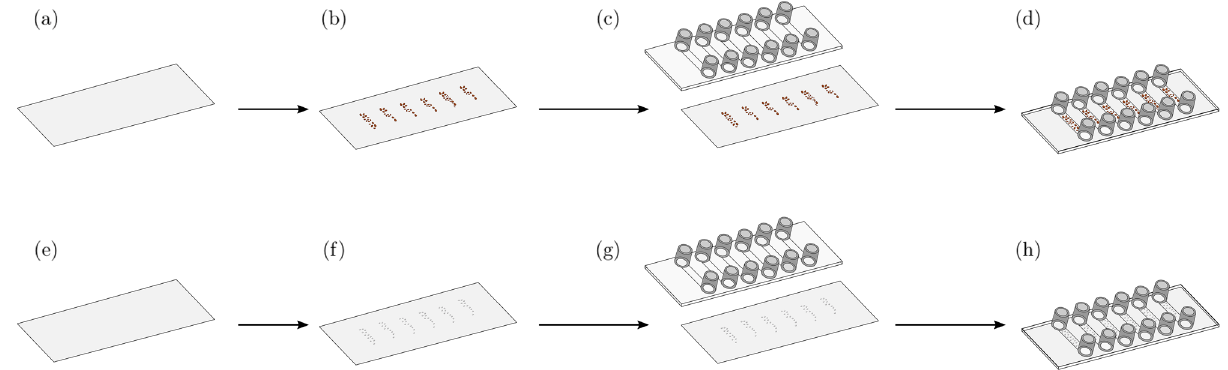
Figure 1. Fabrication and assembly process of sample cells with incorporated calcite seeds ( a – d ) and sand grains ( e – h ). ( a , e ) show the Ibidi polymer slide, and the self-adhesive Ibidi sticky-Slide VI 0.4 was added to the polymer slide in ( c , g ) for the assembly of the sample